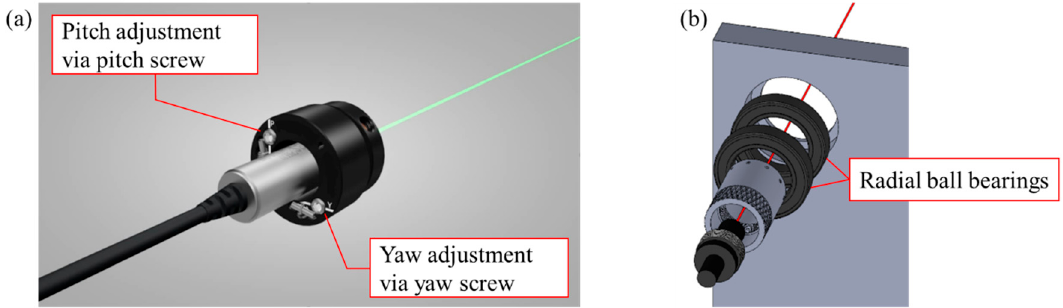
Figure 9. Laser module for calibration. ( a ) Pitch and yaw adjustment via screws. ( b ) Two radial ball bearings for rotating.